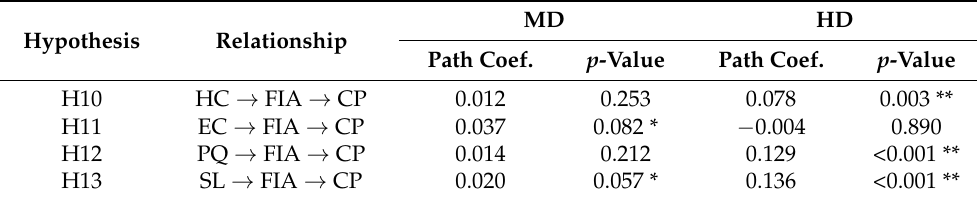
Table 6. Indirect effects of factors towards CP through FIA.